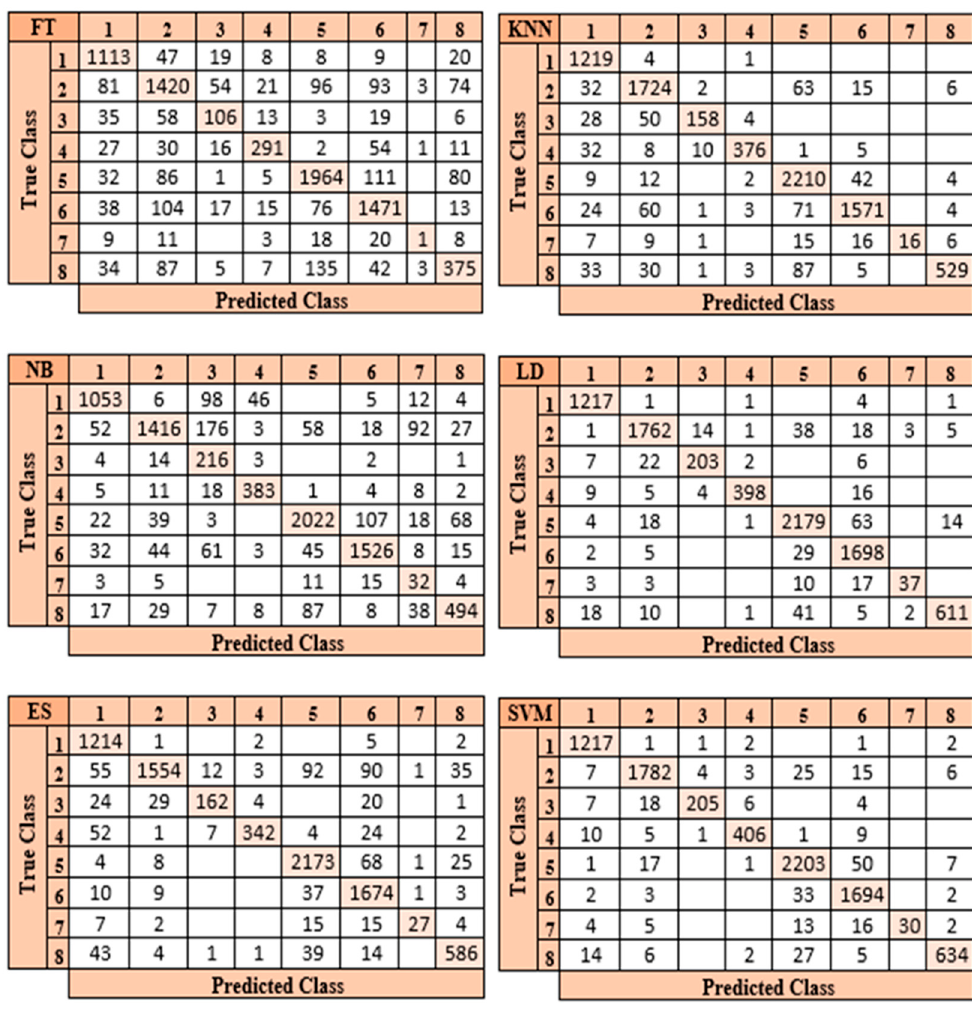
Figure 11. Confusion matrices of the proposed model. Table 6. Performance metrics of the proposed method